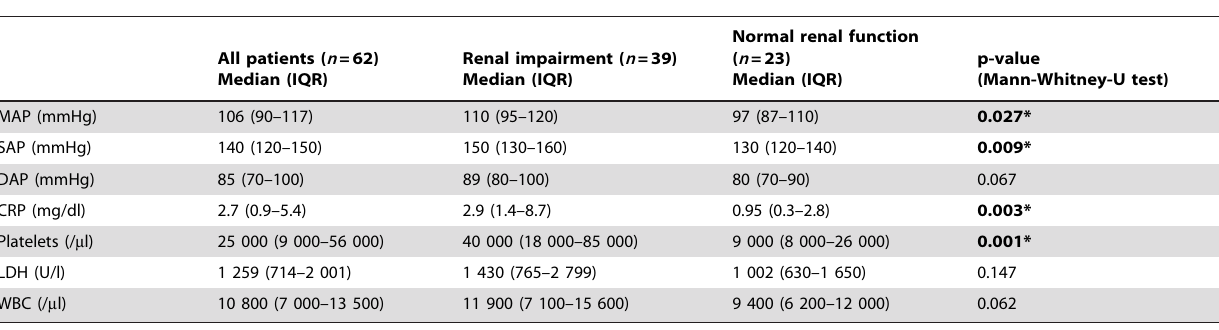
Table 3. Characteristic factors for acute renal failure on